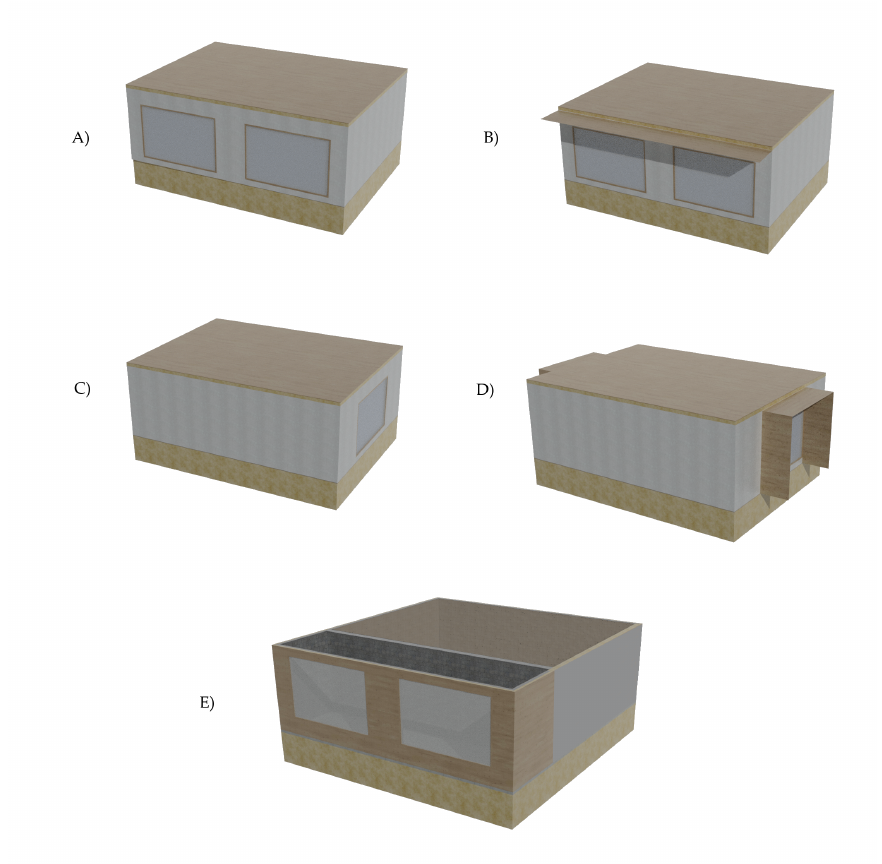
Figure 5. Analyzed BESTEST reference buildings: ( A ) Case 600, 640, 650/900, 940, 950; ( B ) Case 610/910; ( C ) Case 620/920; ( D ) Case 630/930; ( E ) Case